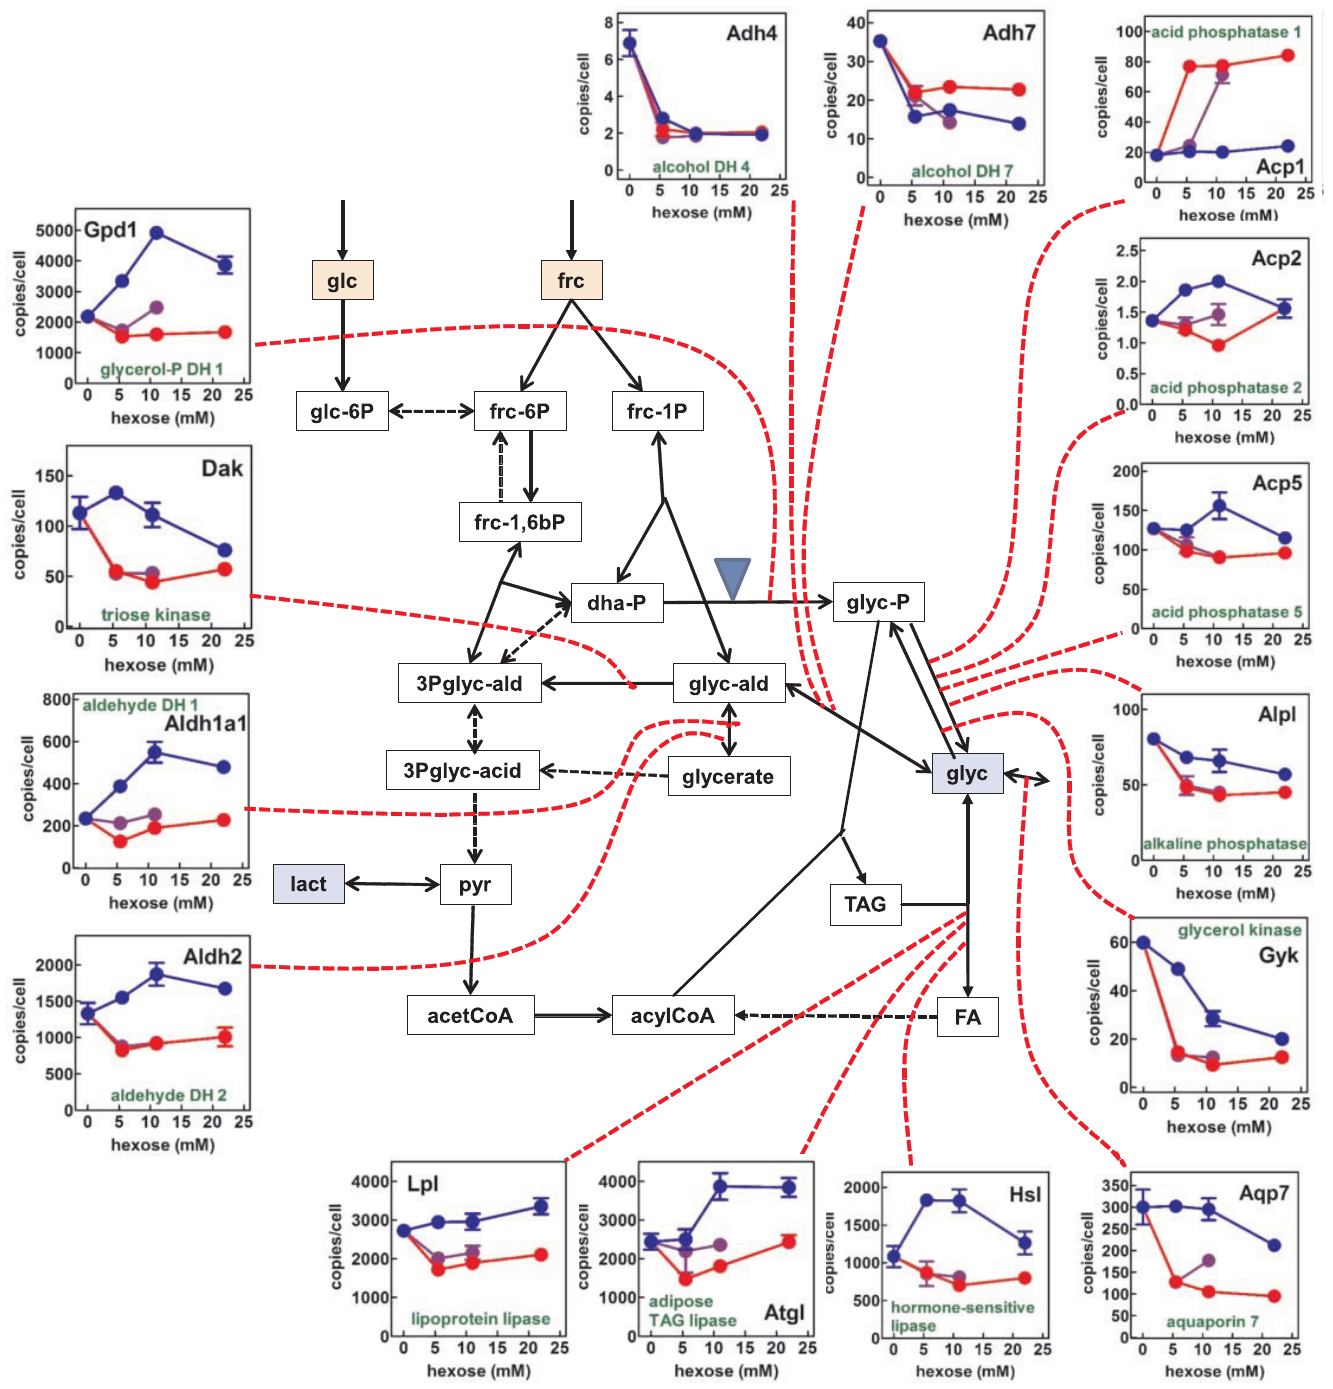
Fig 5. Gene expression of enzymes of glycerol metabolism in 3T3-L1 adipocytes exposed to a medium with varying concentrations of glucose, fructose or a combination of both. Graphical conventions and abbreviations are the same as in Fig 3. The graphs indicate the number of copies of specific mRNAs for the genes (in black) corresponding to the enzymes and transporters (in green) acting on the corresponding paths (linked by red dotted lines). In each graph, the expressions in the presence of glucose are marked in blue, and those with fructose in red. The mixed-hexose groups are marked in purple. The short names used in this graph are the same as in Fig 3. The statistical significance of the differences between groups is presented in the legend to Fig